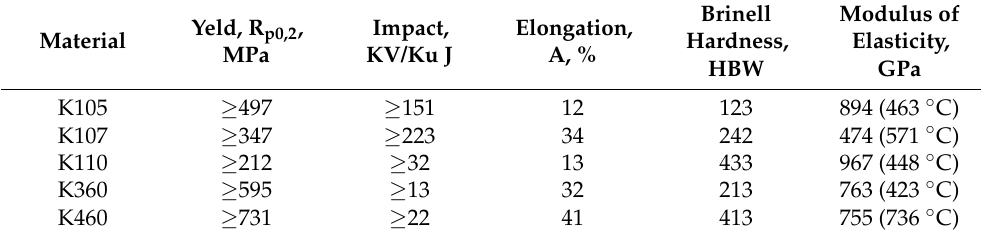
Table 4. Mechanical properties of steels used in the execution of trimming dies